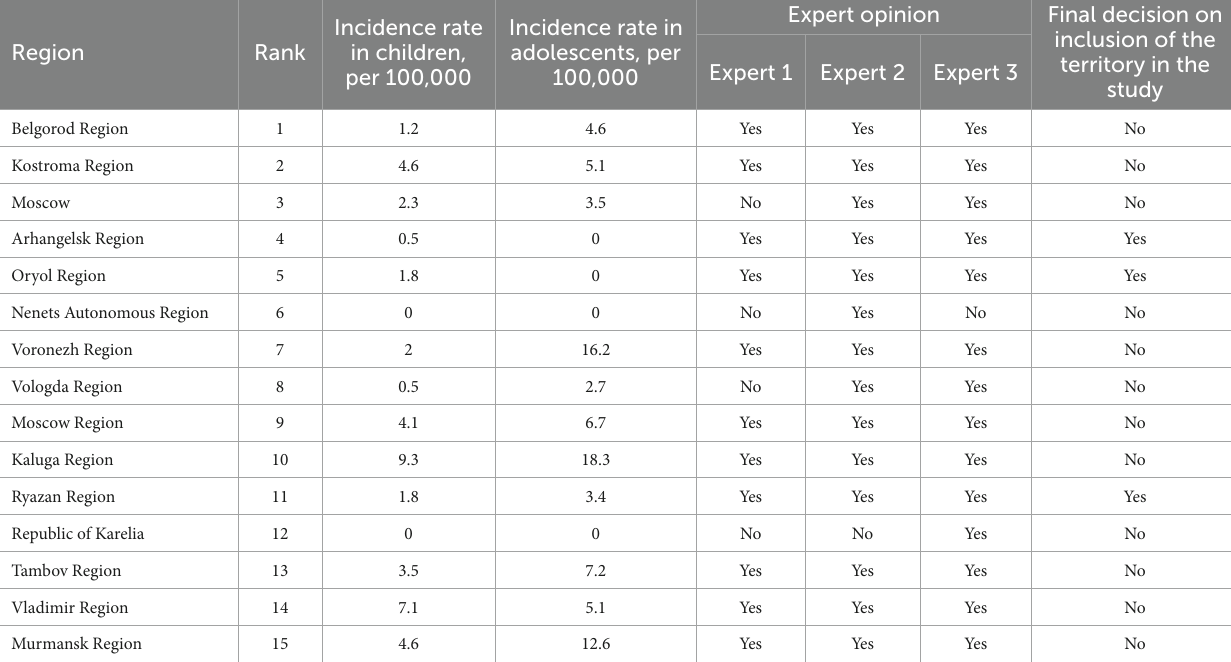
TABLE 1 Results of assessing the regions with low epidemiologic risk for tuberculosis.